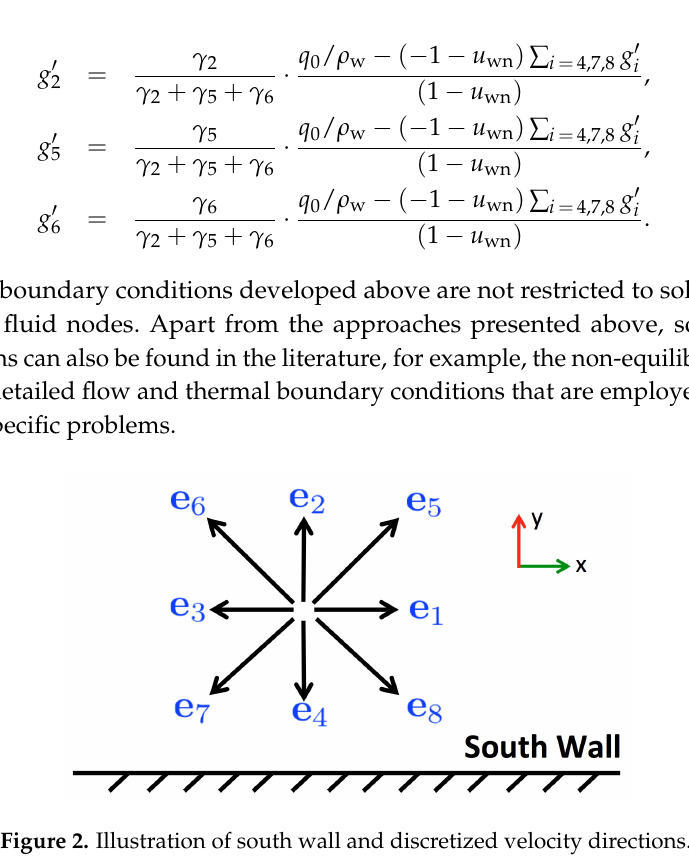
Figure 2. Illustration of south wall and discretized velocity